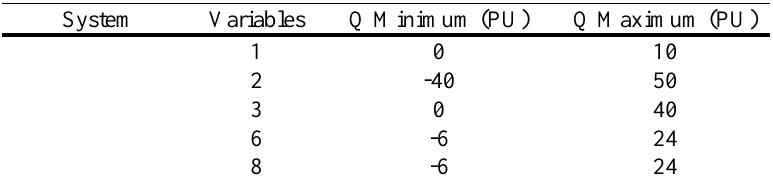
Table 2. Constrains of reactive power generators.